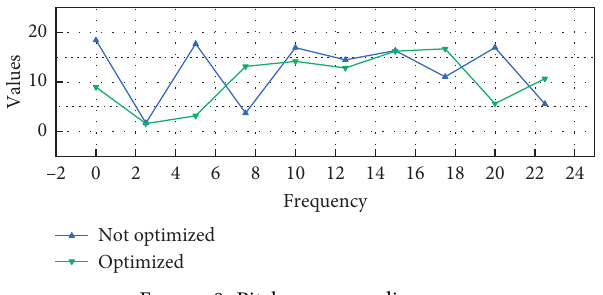
Figure 8: Pitch sequence diagram.